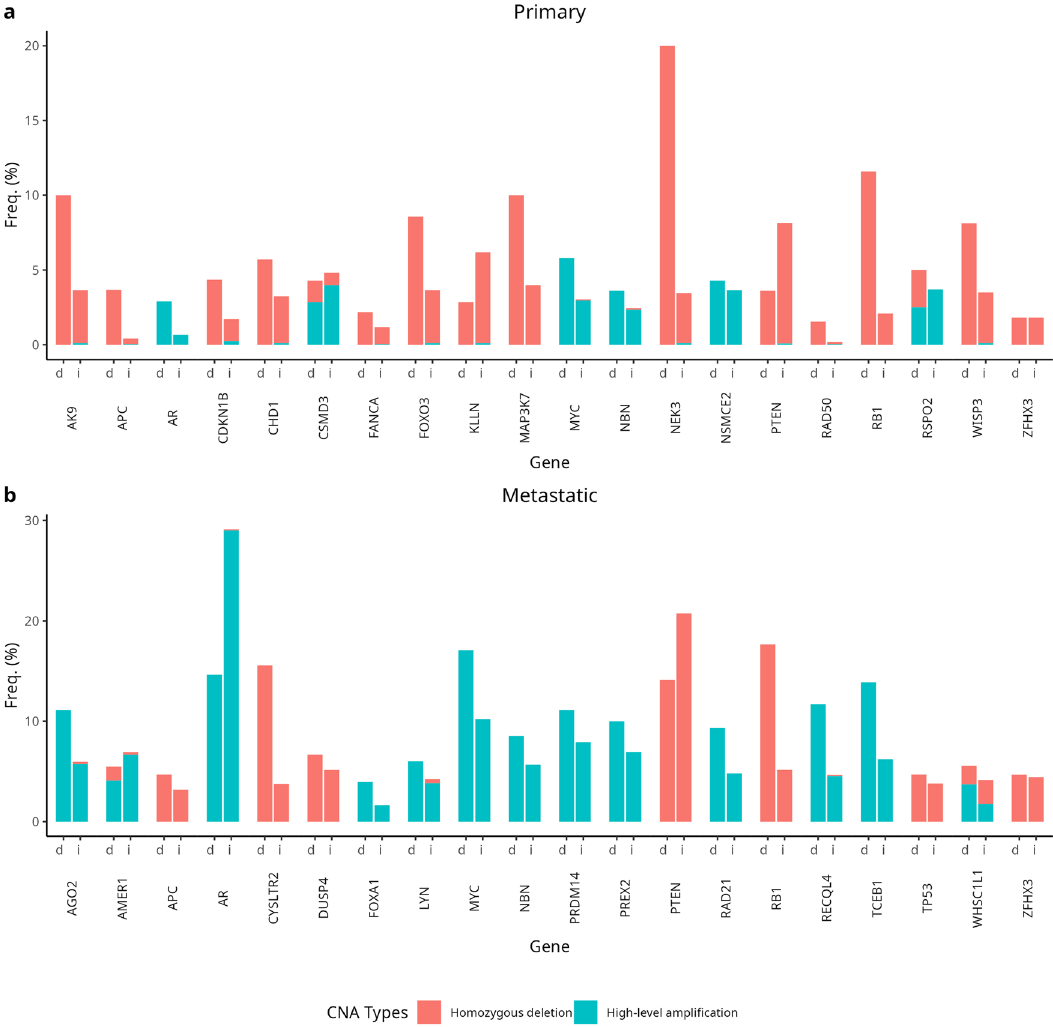
Fig. 4 Pathogenic copy number variant frequency among BRCA2 -de fi cient and BRCA2 -intact tumors. Plots correspond to ( a ) primary and ( b ) metastatic tumors. Figures displays the most commonly altered candidate genes only. d = BRCA2 -de fi cient; i = BRCA2 -intact.